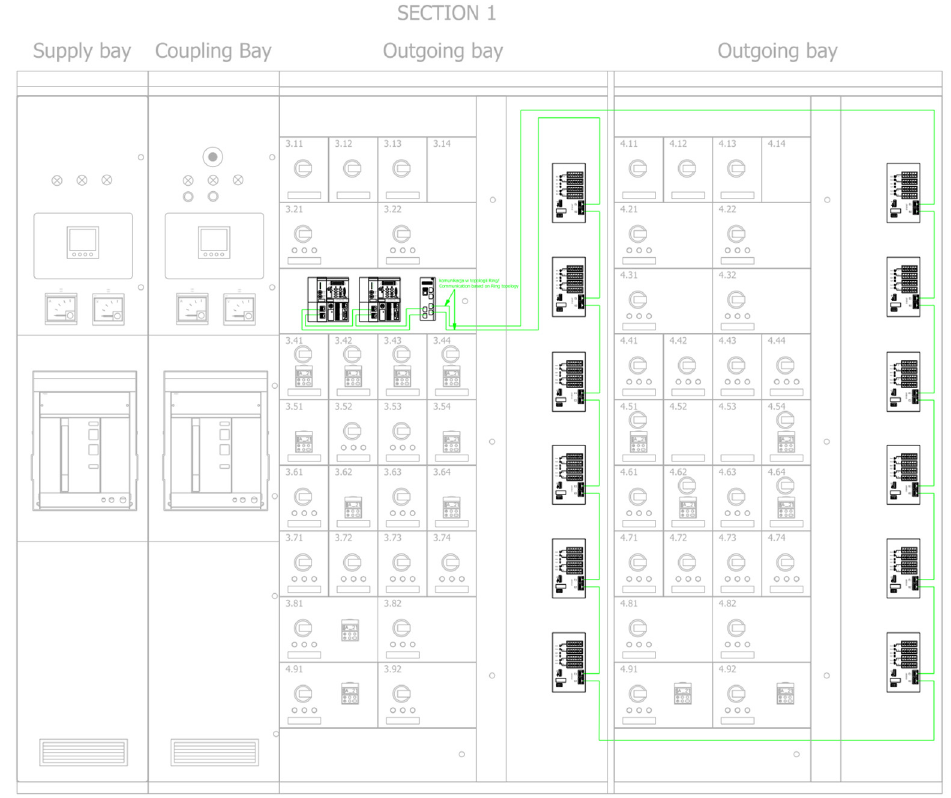
Figure 7. Location of communication modules in the connection compartment in the ring topology.